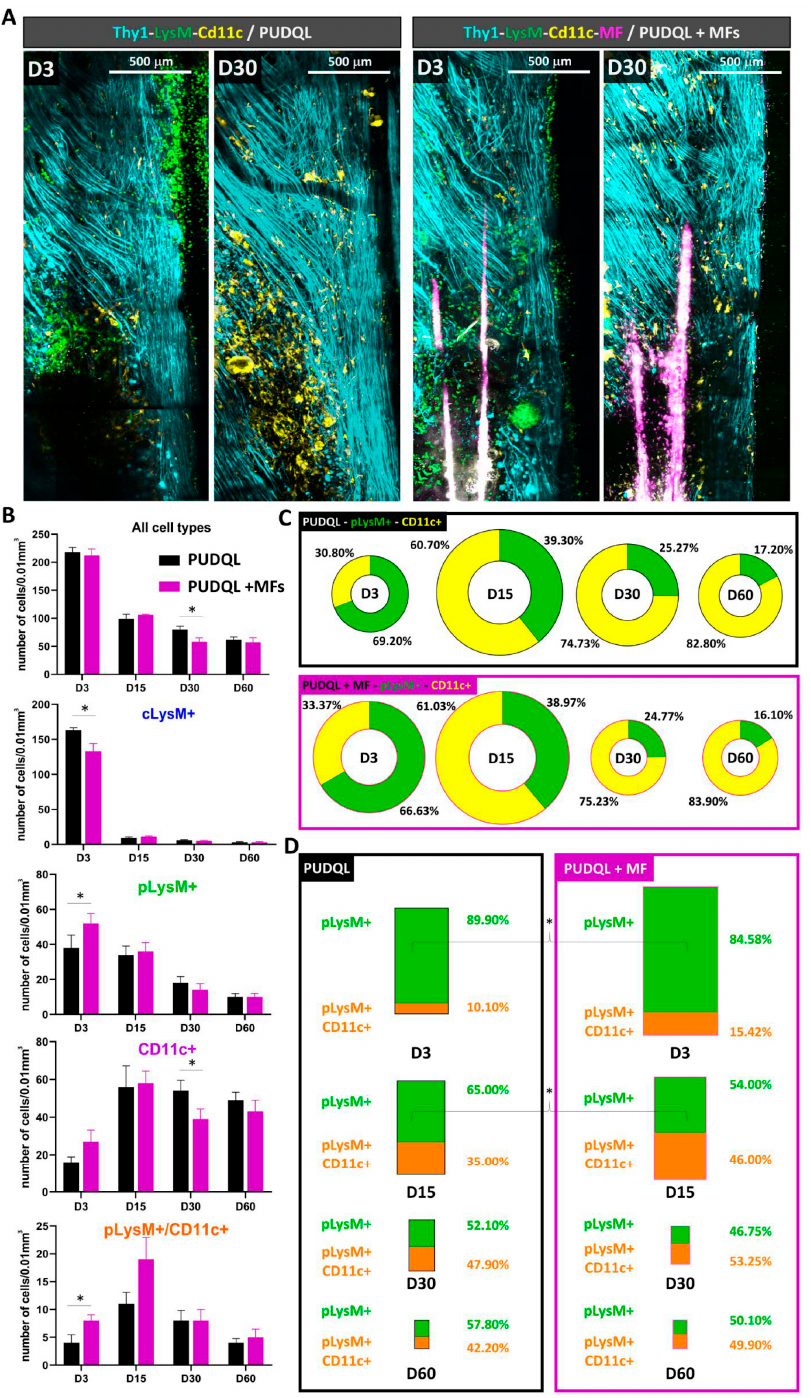
Figure 8. Effect of MFs implantation on post-traumatic inflammation. ( A ) Representative images of the same hemi-spinal cord three days (D3) and 30 days (D30) after PUDQL or PUDQL +MF implantation. ( B ) Quantitative evolution of fluorescent cells densities considered as a whole (top) or as individual color coded subsets in PUDQL (n = 5) and PUDQL + MFs (n = 5) animals. Data are shown as mean ± SEM. ( C ) Circular graphs showing the relative percentage of pLysM+ and CD11c+ cells 3, 15, 30 and 60 days after PUDQL or PUDQL+MF implantation. Diameter of the circles is proportional to the total number of pLysM+ and CD11c+ cells densities quantified at each time point. ( D ) Bar graphs showing the relative percentage of pLysM+/CD11c+ cells among pLysM+ cells 3, 15, and 30 and 60 days after PUDQL or PUDQL+MF implantation. Height of the bar is proportional to the total number pLysM+ and pLysM+/CD11c+. * p <